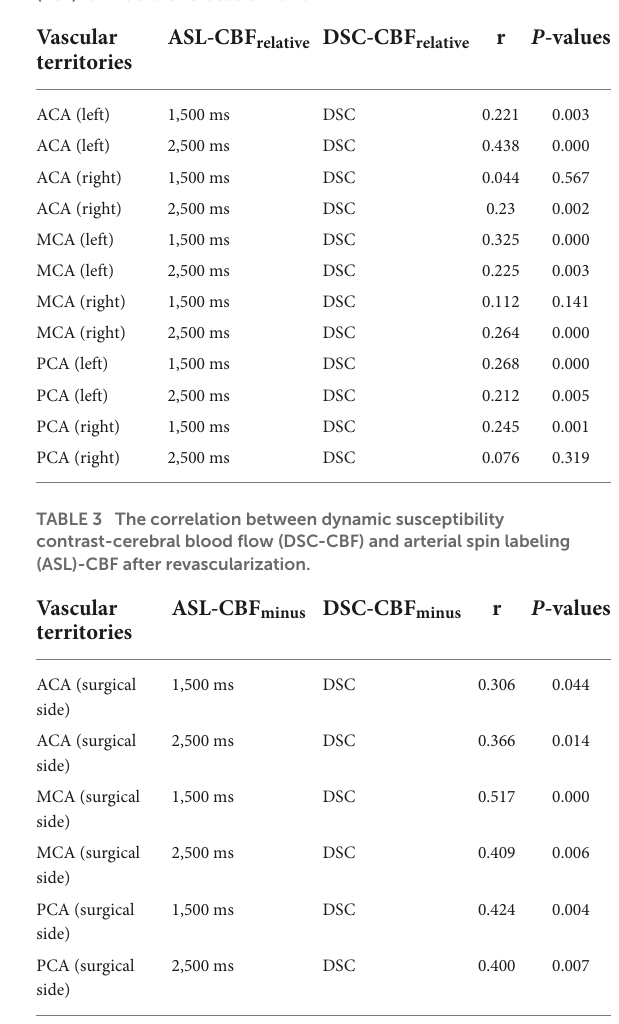
TABLE 1 The clinical and imaging characteristics of the patients with moyamoya disease (MMD).